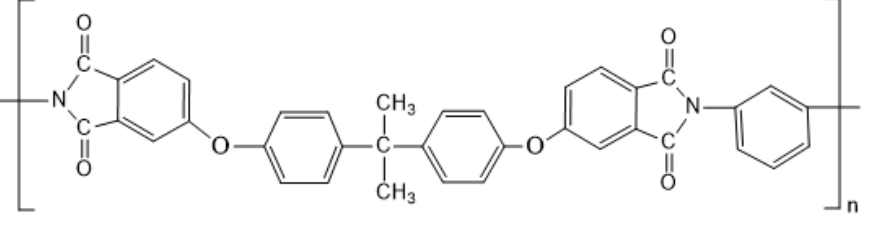
Figure 1. Chemical structure of PEI.